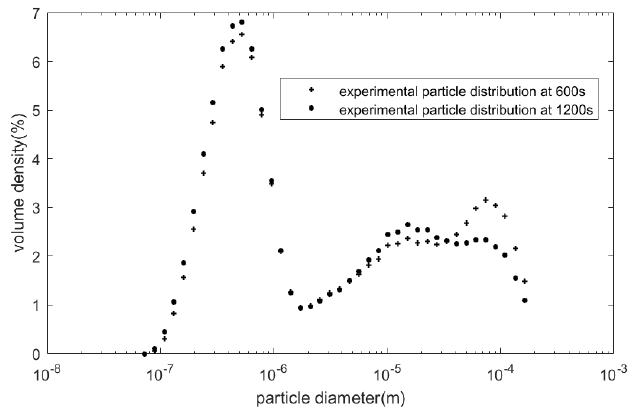
Figure 10. Particle size distribution of the filter cake at 600 and 1200 s.